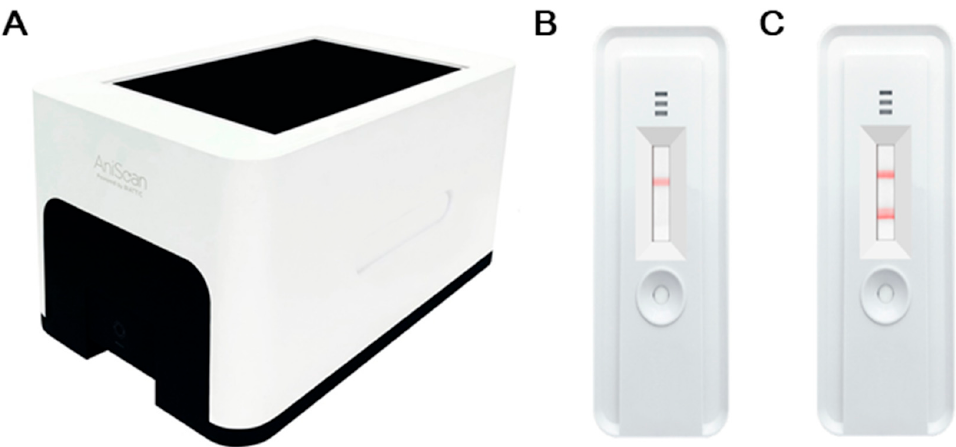
Figure 1. Representative images of the Aniscan cancer detection kit: ( A ) aniscanner, ( B ) a kit from a healthy control sample, and ( C ) a kit from a malignant tumor sample.